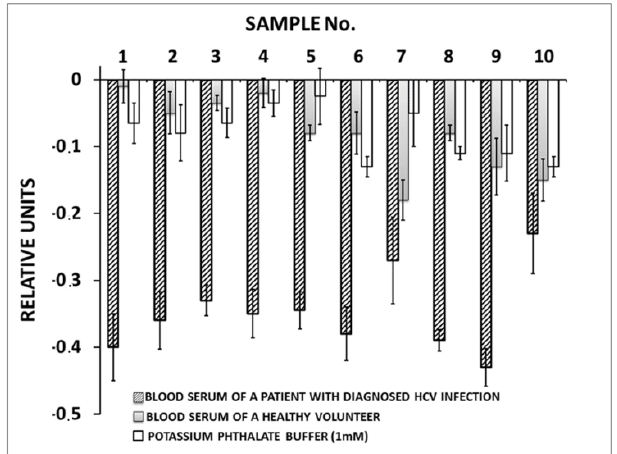
Figure 5. Results obtained upon analysis of ten serum samples of hepatitis C patients with the SOI-NW-based aptasensor upon using p-type SOI-NW chip. Experimental conditions: 1 mM potassium phthalate buffer, pH 5.1, V g = ( − 45) V, V ds = ( − 0.2) V, V = 105 μL. Each experiment was performed in three technical replicates ( n =